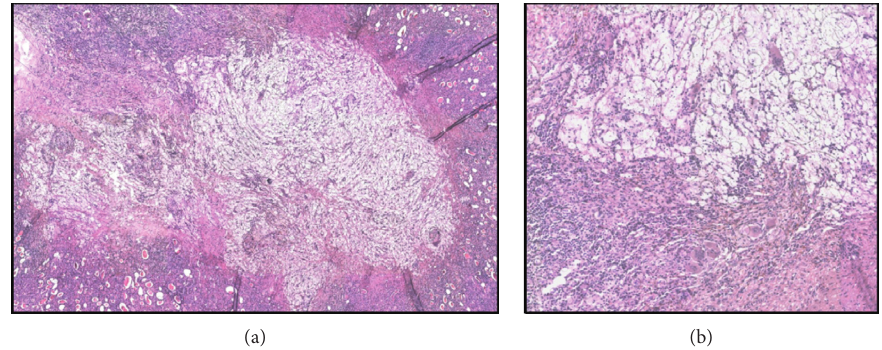
Figure 2: (a) H & E 4x: acute pyelonephritis, with abscessualization of the calices and pelvis and xanthogranulomatous chronic in- flammation; (b) H & E 10x: detailed image of the typical multinucleated giant cells in the context of